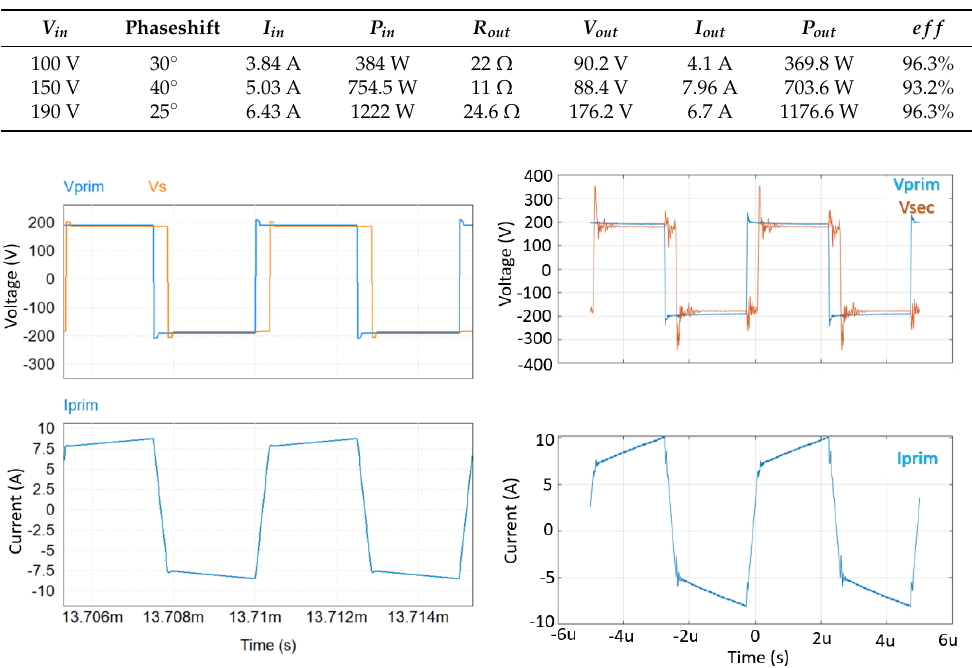
Table 8. Measurement results for three different input voltages.